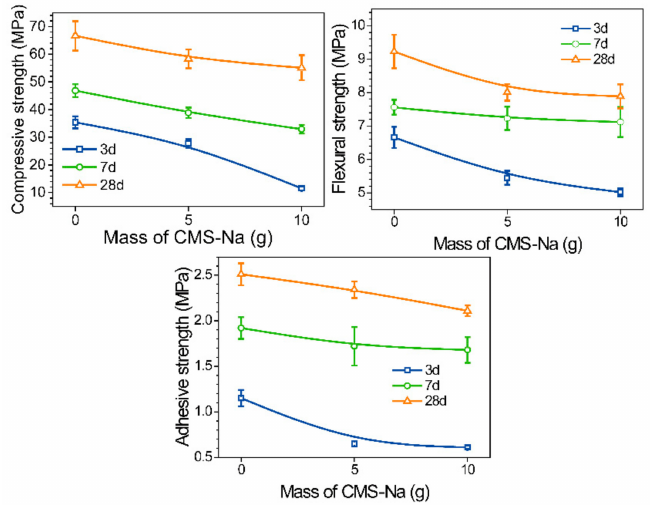
Figure 4. E ff ect of CMS on the compressive ( A ), flexural ( B ) and adhesive ( C ) strength of